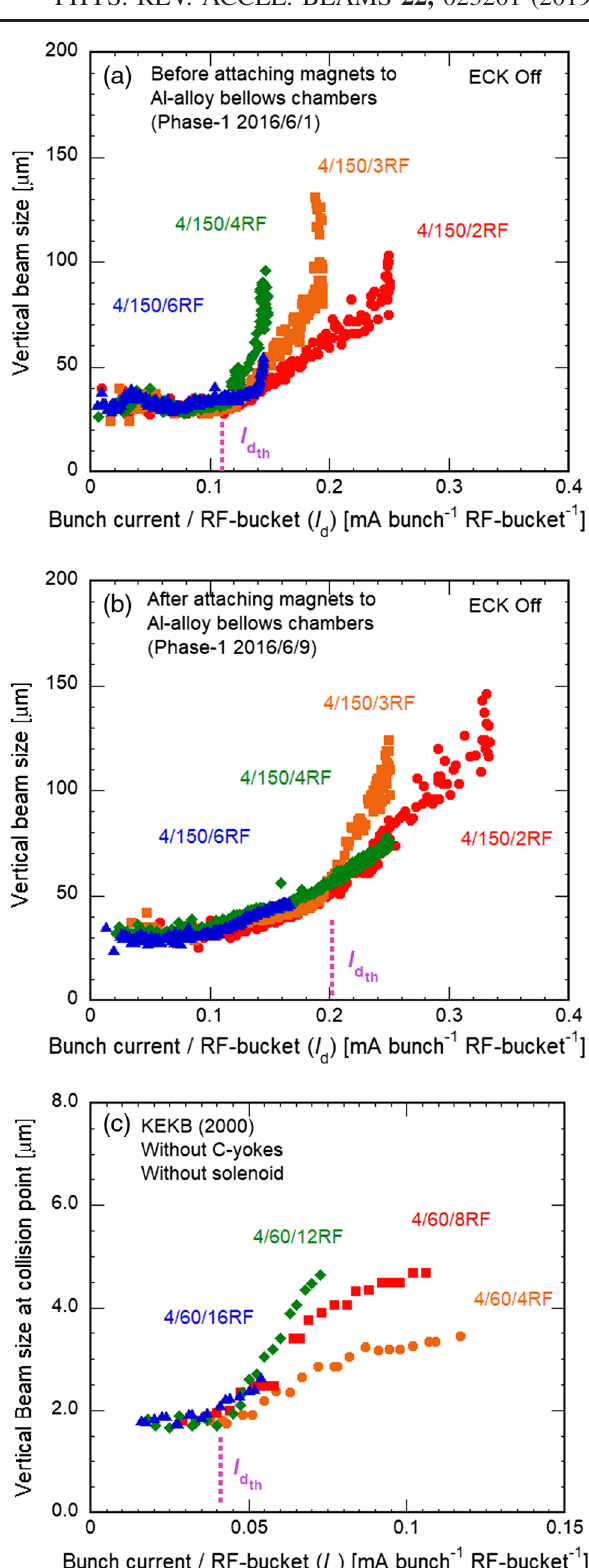
FIG. 4. Measured vertical beam sizes as a function of the current line density ( I d ) for several bunch fill patterns measured (a) before and (b) after attaching PM units to Al-alloy bellow chambers in phase-1 commissioning,and (c) in the early stage of the KEKB